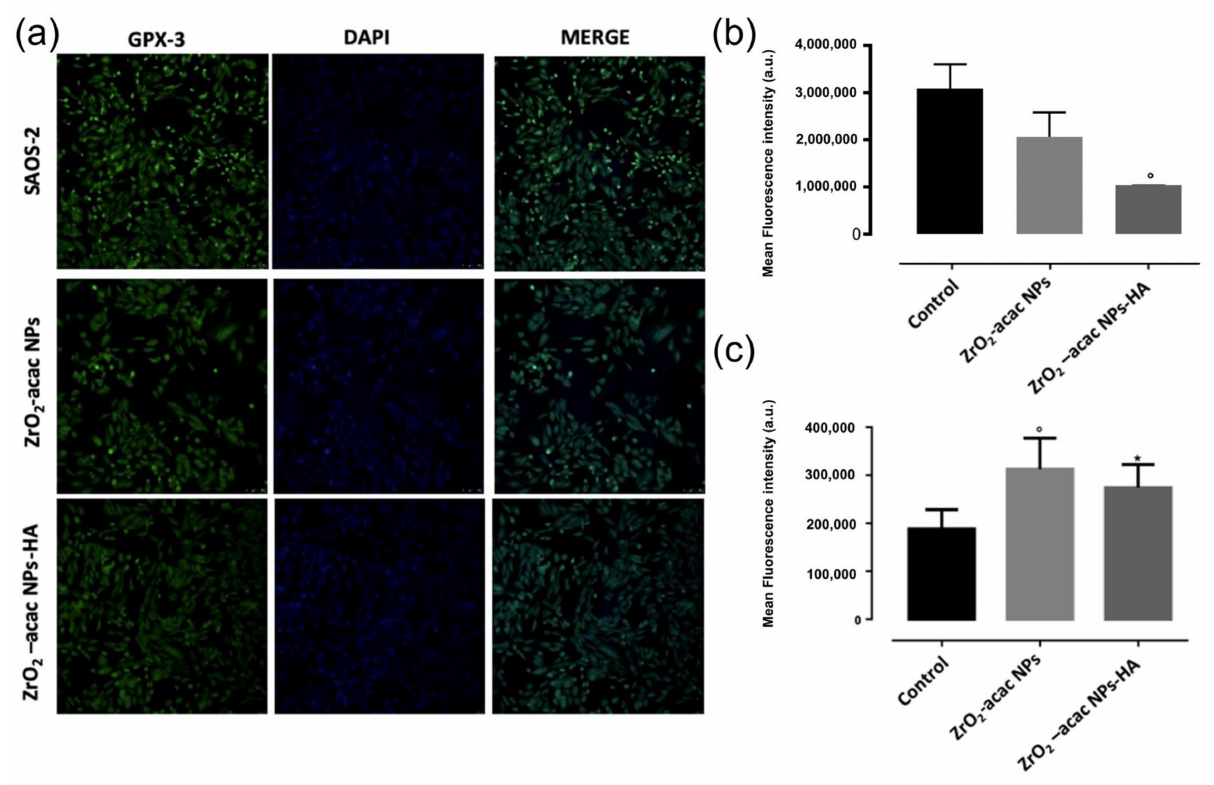
Figure 7. ( a ) Confocal microscopy investigation of Gpx-3 expression on SAOS-2 cells after 48 h of incubation with 50 µ g mL − 1 of ZrO 2 -acac NPs and ZrO 2 -acac NPs-HA, and ( b ) quantification of Gpx expression by ImageJ software. ( c ) ROS generation by DCF-DA assay after incubation of SAOS-2 cells with 50 µ g mL − 1 of ZrO 2 -acac NPs or ZrO 2 -acac NPs-HA. The level of significance was set at probabilities of p < 0.05 (*) and p < 0.01 ( ◦ ). The scale bar is 250 µ m. The results are expressed as the mean ± s.d. ( n ≥ 3). Non-significant data are not